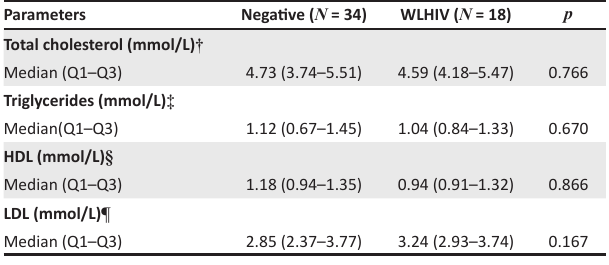
TABLE 3: Median lipogram values.